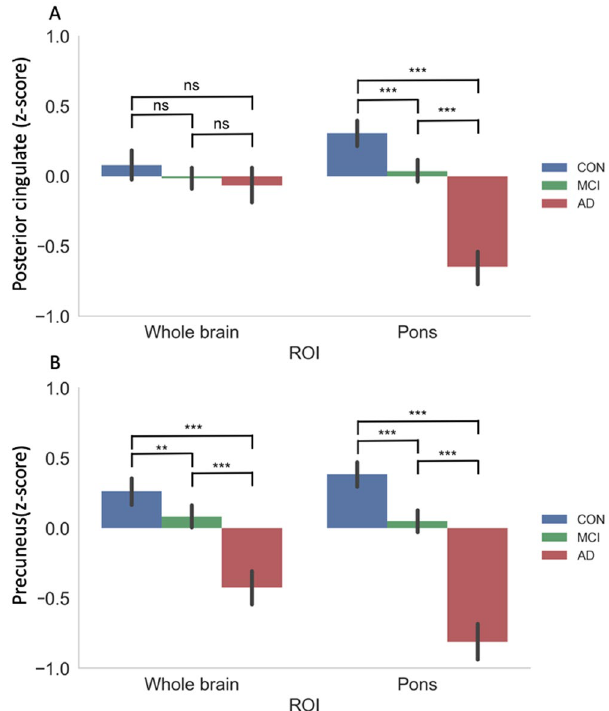
Figure 2. Effects of whole brain and pons reference regions on group differences between healthy controls, mild cognitive impairment (MCI), and Alzheimer’s disease (AD) patients using PVE corrected data. Two regions susceptible to hypometabolism in Alzheimer’s disease, the posterior cingulate ( A ) and precuneus ( B ), were analyzed. Cerebral metabolic rate of glucose (CMRg) are displayed as z-scores. ** p < 0.01, *** p <